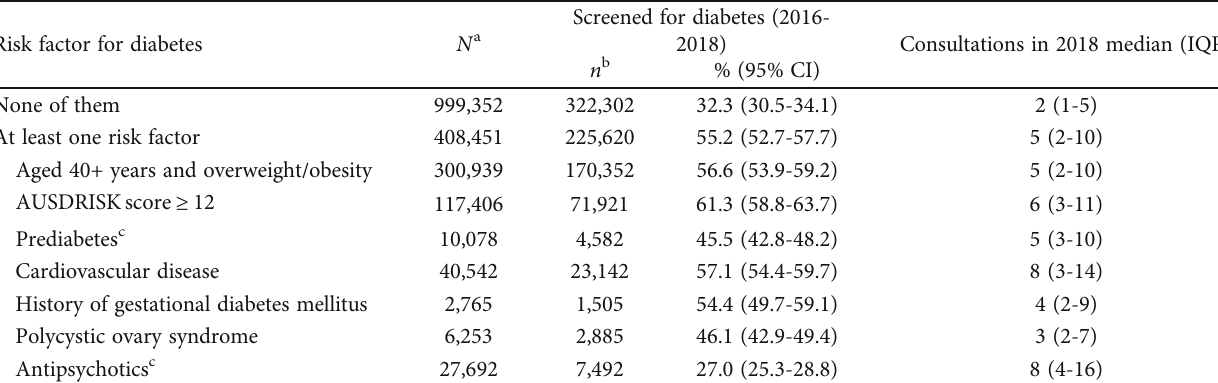
Table 2: Proportion of diabetes screening a according to the presence or not of risk factors for diabetes. Regular patients aged 18+ years ( n = 1,407,803 ).